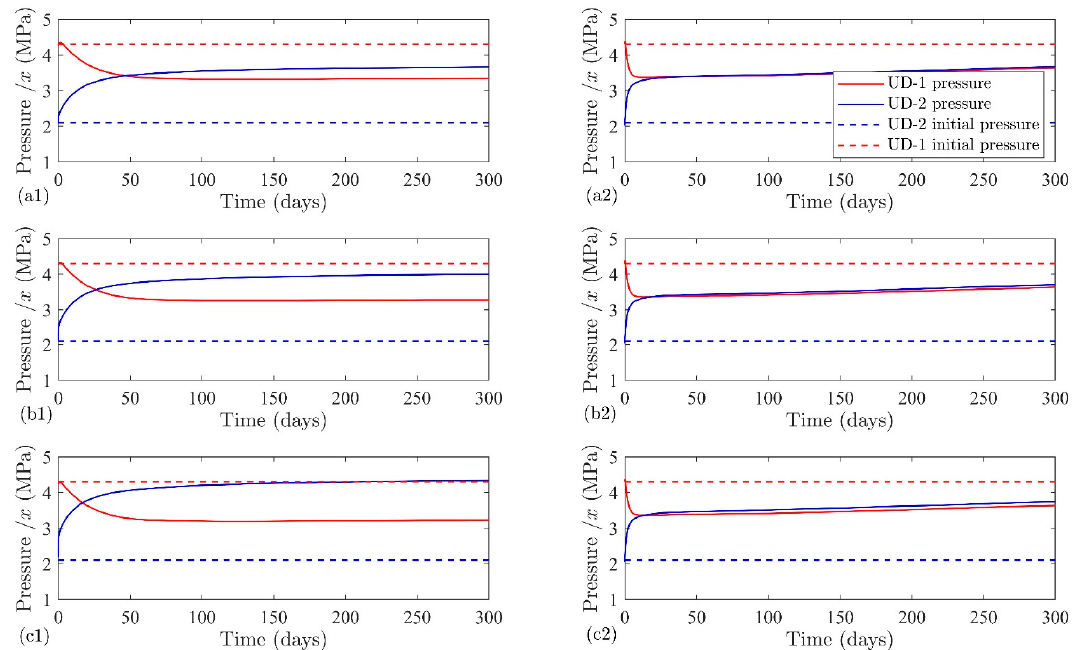
Figure 13. Simulated pressures at the injection and production wells for the injection flow rate of ( a1 , a2 ) x L/s, ( b1 , b2 ) 2 x L/s, and ( c1 , c2 ) 3 x L/s after the permeability enhancement through the considered chemical stimulation. The left column shows a permeability enhancement by a factor of 10, and the right column shows a permeability enhancement by a factor of 100 with respect to the initial values.